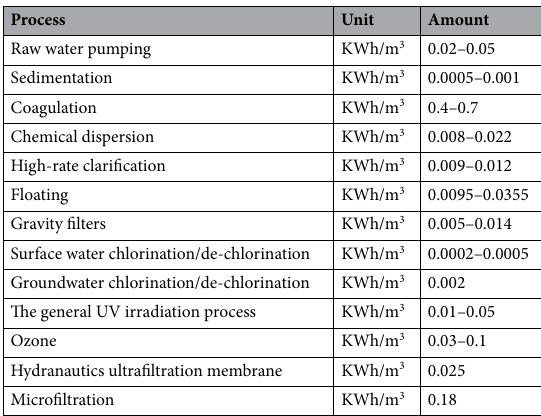
Table 16. Energy consumption intensity for treatment plant’s processes 92